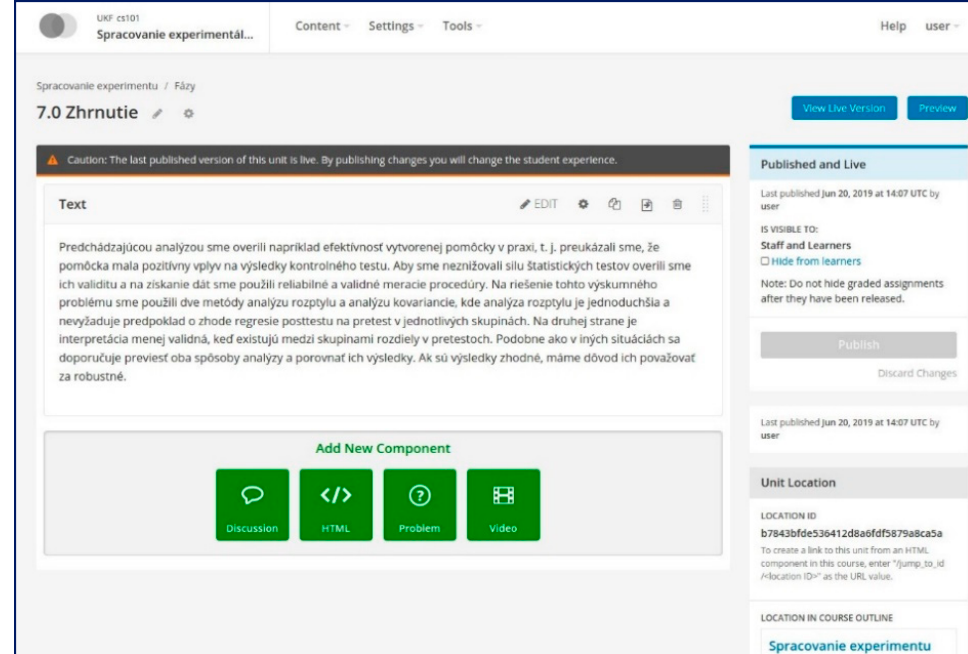
Figure 1. edX Studio environment.